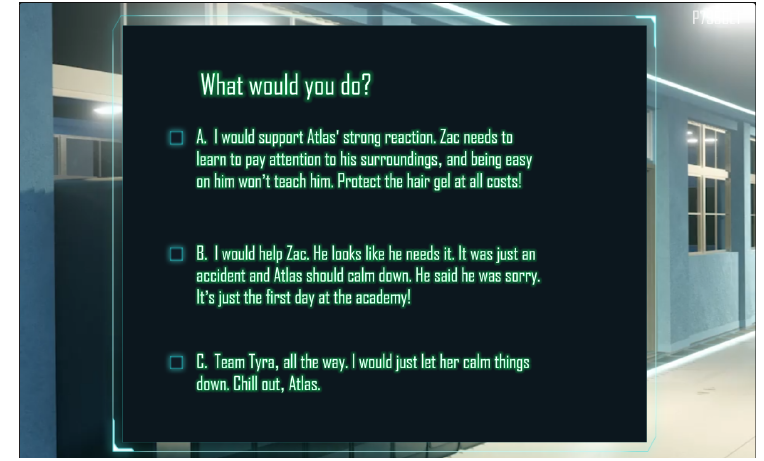
Figure A3. Example of choices in a behavioral scenario.